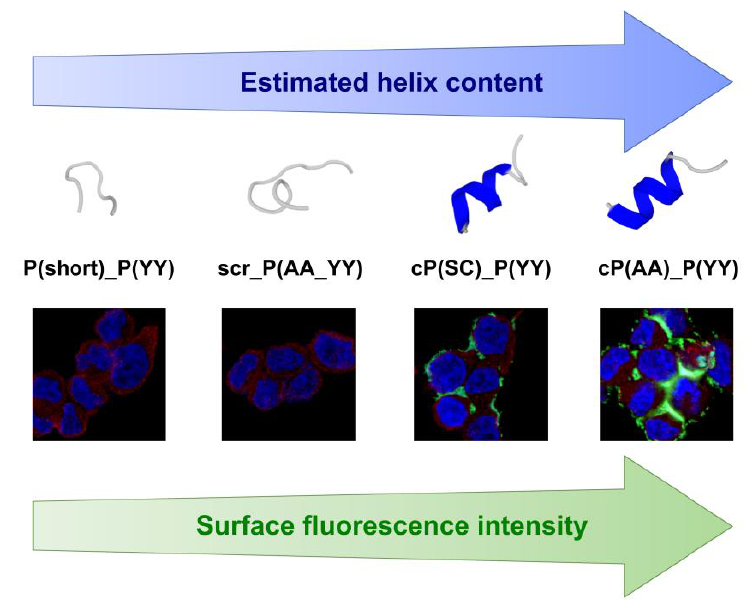
Figure 7. Estimated α -helical content of the HER2-binding peptides is proportional to the fluorescence intensity that was detected on the surface of the MDA-MB-453 cells that were incubated with the CF-labeled peptides. Secondary structure estimation of the peptides was performed by the PEP-FOLD3 de novo secondary structure prediction server. The color grey shows disordered regions, and thepredicted α -helical content is marked with blue. Cell imaging was carried out by confocal microscopy where the CF signal and nucleus staining are represented by green and blue, respectively. HER2 was detected with an anti-HER2 antibody and a TRITC-conjugated secondary antibody, as shown in red.